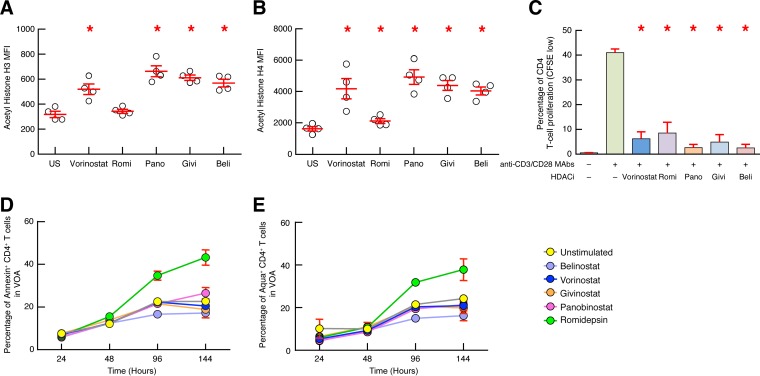
Assessment of functional activity and toxicity of the HDACis tested. (A and B) Mean fluorescence intensity (MFI) of acetyl histone H3 (A) or histone H4 (B). Blood mononuclear cells isolated from 4 HIV-seronegative individuals were exposed or not (unexposed control [US]) to vorinostat (400 nM), romidepsin (Romi [5 nM]), panobinostat (Pano [15 nM]), givinostat (Givi [400 nM]), or belinostat (Beli [400 nM]) for 24 h, and acetyl histone H3 or H4 MFI was analyzed on CD4 T cells by flow cytometry. (C) Percentage of CD4 T-cell proliferation upon HDACi treatment. CFSE-labeled blood mononuclear cells isolated from 3 HIV-seronegative individuals were exposed or not (US) to vorinostat (400 nM), romidepsin (5 nM), panobinostat (15 nM), givinostat (400 nM), or belinostat (400 nM) for 24 h and stimulated for 6 days with anti-CD3/CD28 MAbs, and the percentage of proliferating CD4 T-cell proliferation (CFSE low) was assessed by flow cytometry. The percentage of annexin V-positive (D) or Aqua-positive (E) CD4 T cells was assessed at 24, 48, 96, and 144 h.CD4 T cells isolated from 3 HIV-uninfected individuals were exposed or not to vorinostat (400 nM), romidepsin (5 nM), panobinostat (15 nM), givinostat (400 nM), and belinostat (400 nM) in the presence of allogeneic CD8-depleted PBMCs isolated from HIV-uninfected subjects. Red horizontal lines or histograms correspond to the mean, and red error bars correspond to the SEM. Red asterisks indicate statistical significance (P < 0.05) compared to unexposed conditions. Statistical significance (P values) was obtained using a one-way ANOVA (Kruskal-Wallis test) followed by a paired t test (A to C).